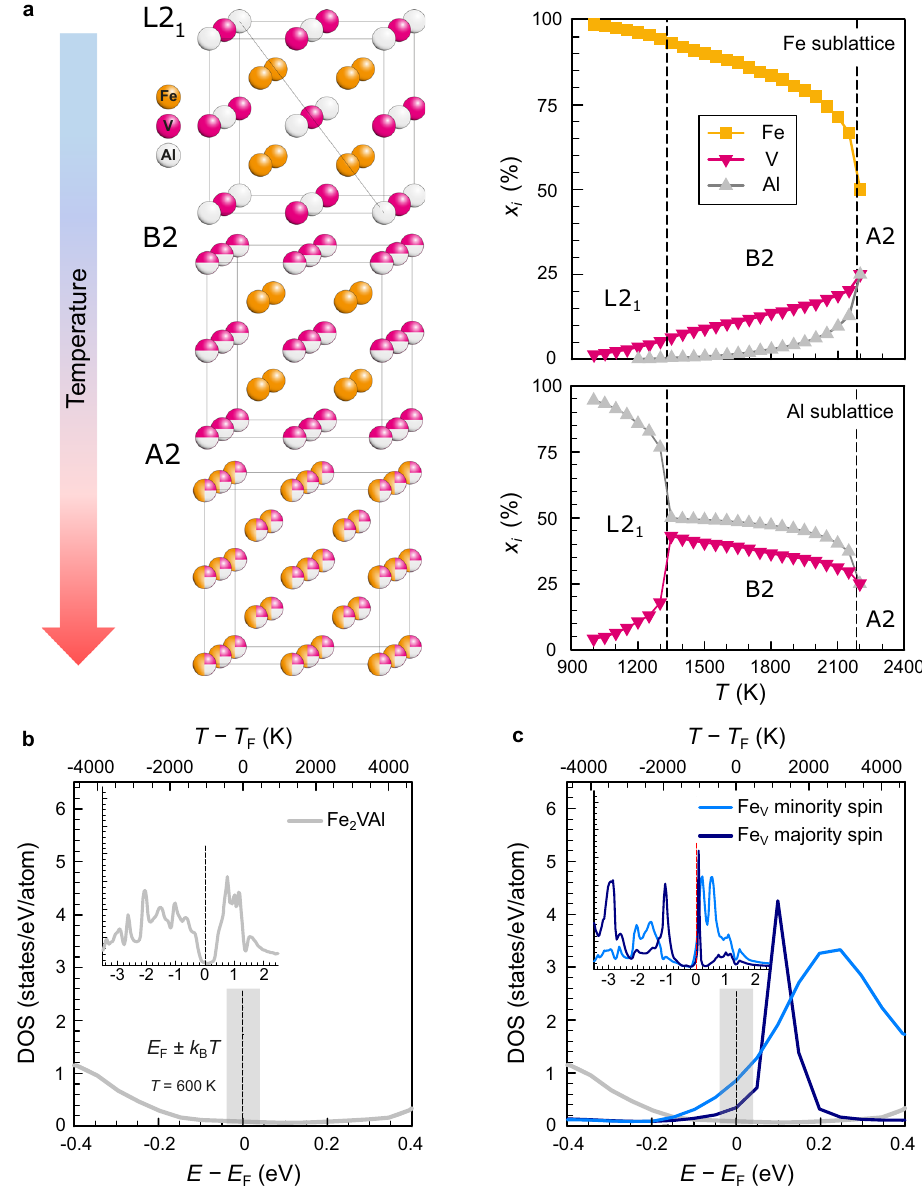
Fig. 2 Temperature-induced modi fi cations of the electronic structure in Fe 2 VAl due to antisite defects. a Order – disorder transitions and Monte Carlo- simulated concentrations of site occupancies in the L2 1 , B2 and A2 high-temperature phases of Fe 2 VAl. b , c Spin-polarised electronic density of states (DOS) for pure Fe 2 VAl and single-impurity Fe V antisite defects,